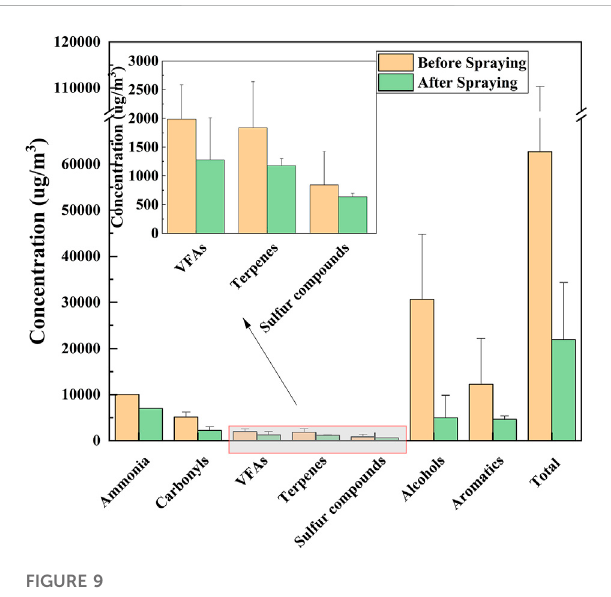
FIGURE 9 Concentration of the total and each group before and after spraying.